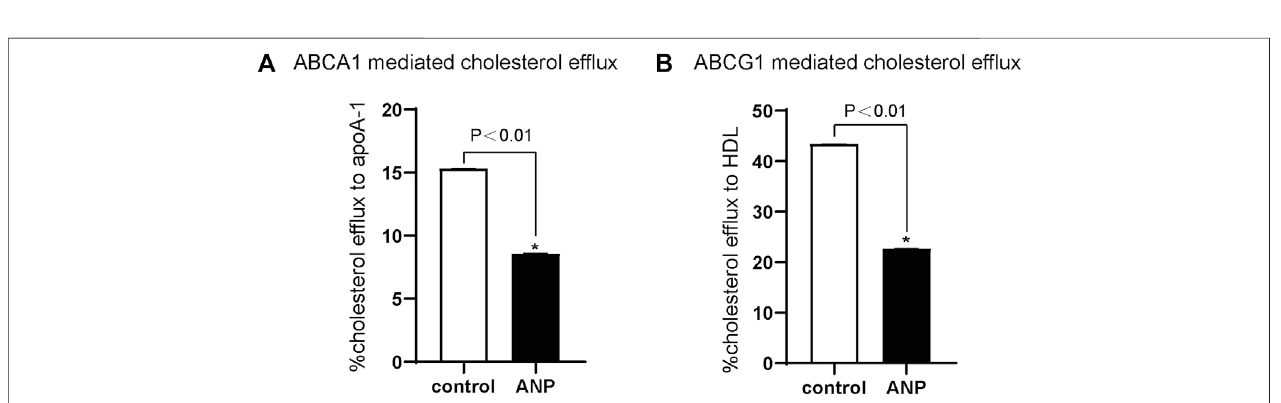
FIGURE 3 | ANP inhibited ABCA1- and ABCG1-mediated cholesterol ef fl ux. THP-1 cells were treated with the absence or presence of 10 − 5 mol/L ANP for 72 h. Cholesterol ef fl ux was measured using apoA- Ⅰ (15 μ g/ml) and HDL (50 μ g/ml) as lipid acceptors. A: ABCA1-mediated cholesterol ef fl ux to apoA- Ⅰ was attenuated in the ANPgroup.B:ABCG1-mediatedcholesterolef fl uxtoHDLwasdecreasedintheANPgroup.* p < 0.01,comparedwiththecontrolgroup.Dataareexpressedasmean ± SEM of three independent